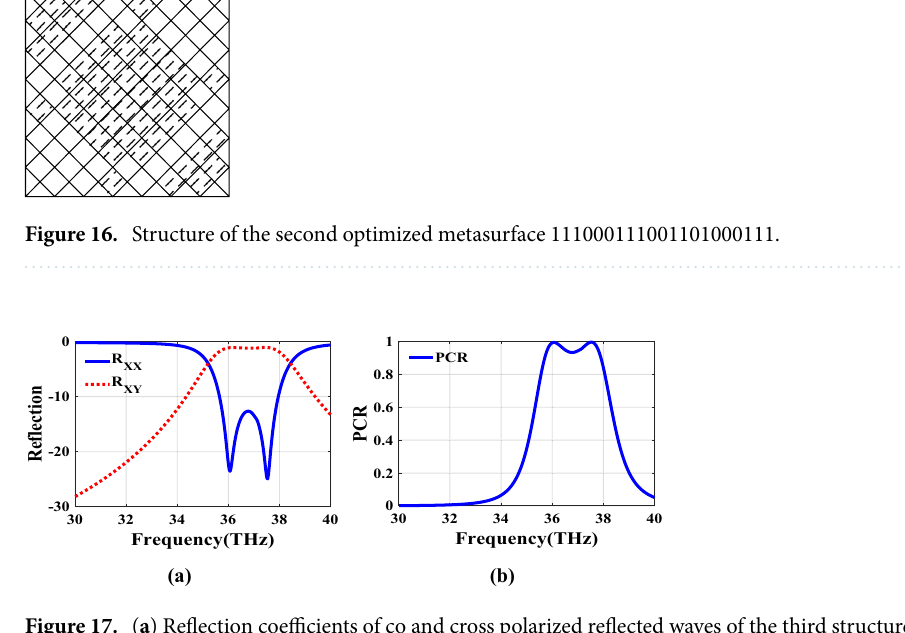
Figure 17. ( a ) Reflection coefficients of co and cross polarized reflected waves of the third structure, ( b ) PCR of the third structure.